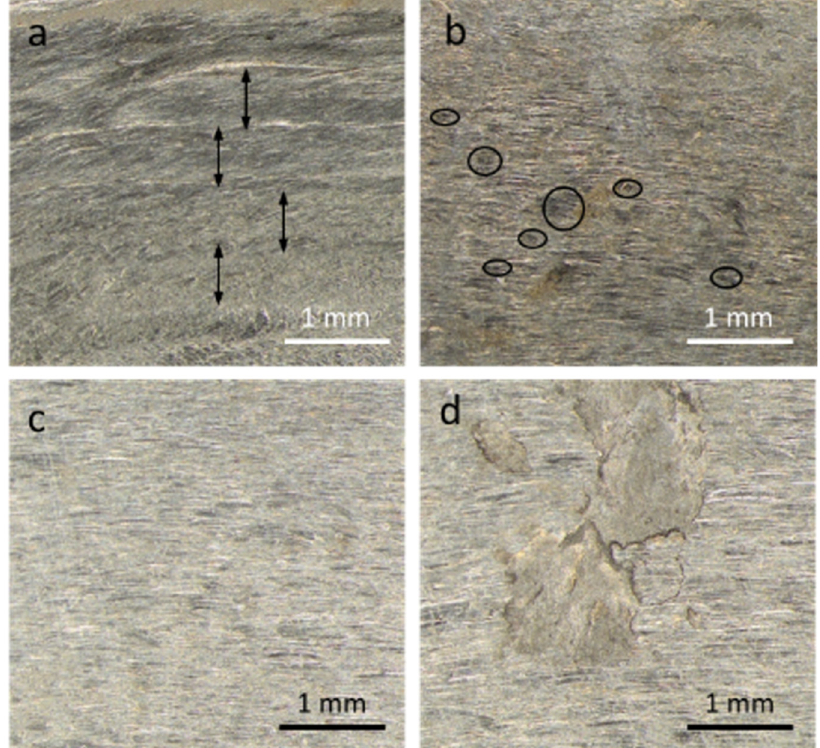
Figure 7. Surfaces of a part obtained by SPIF process at 400 °C with a WC tool of 12 mm diameter; surfaces correspond to 45° with respect to the rolling direction and from different zones of the part; ( a – d ) photographs correspond to zones 1 to 4 according to the reference of Figure 2. Zone 4 is the deepest.